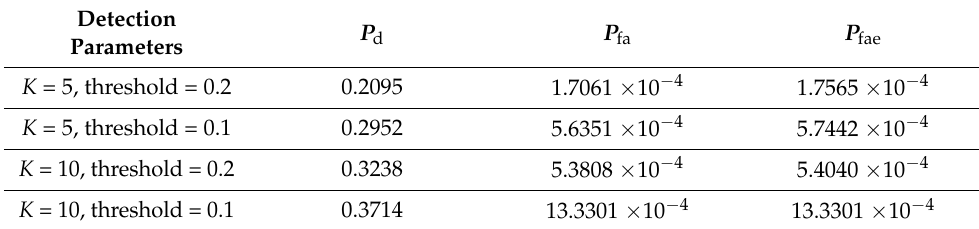
Table 5. P d and P f of the vessel with MMSI = 657199400 in a time interval of 1 h (18–19 h).